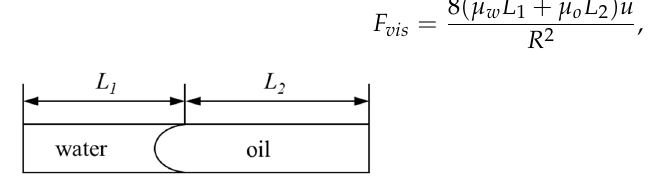
Figure 2. Schematic diagram of the oil and water distribution in a capillary tube.